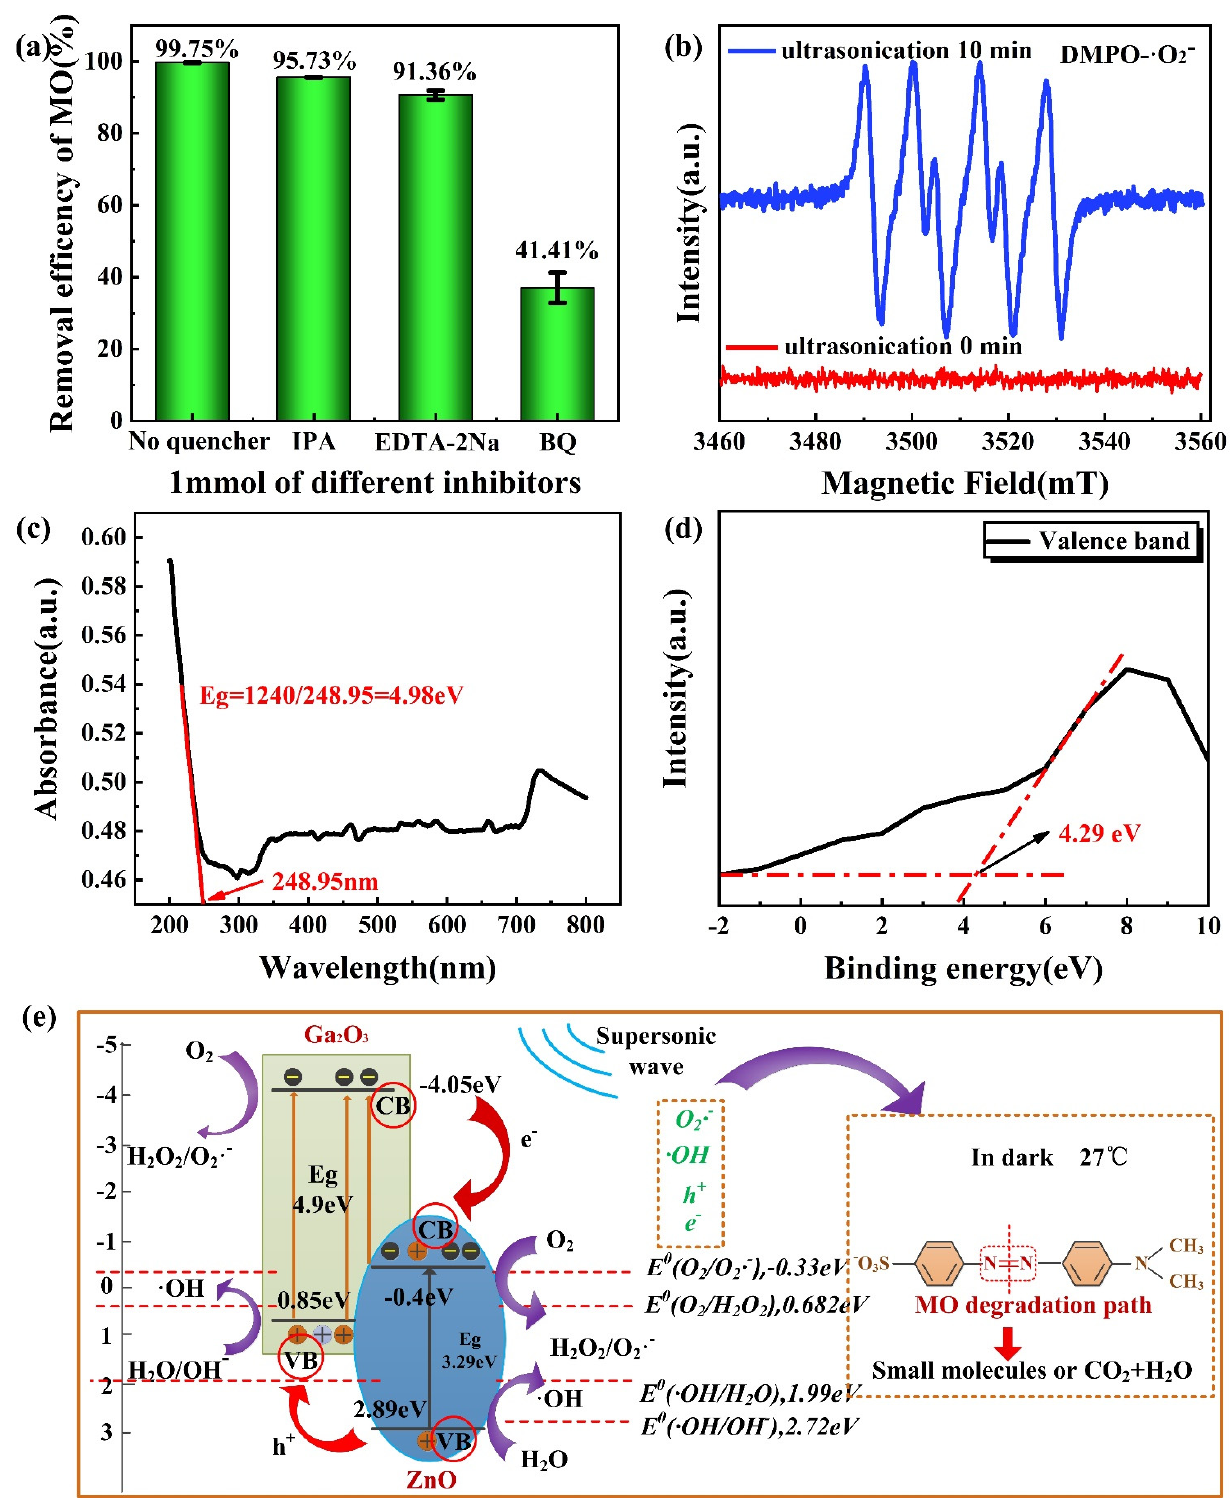
Figure 9. ( a ) The influence of removal rates of MO with 1 mmol BQ, IPA, EDTA – 2Na and no quencher, ( b ) the high-resolution XPS spectrum for the sample of Ga 2 O 3 /ZnO corresponding valence band edge, ( c ) UV – Vis diffuse reflectance spectra of Ga 2 O 3 /ZnO and corresponding bandgap, ( d ) the ESR spectra of Ga 2 O 3 /ZnO composite for detecting DMPO – ·O 2 − , and ( e ) Ga 2 O 3 /ZnO composite transfer mechanism during degradation.